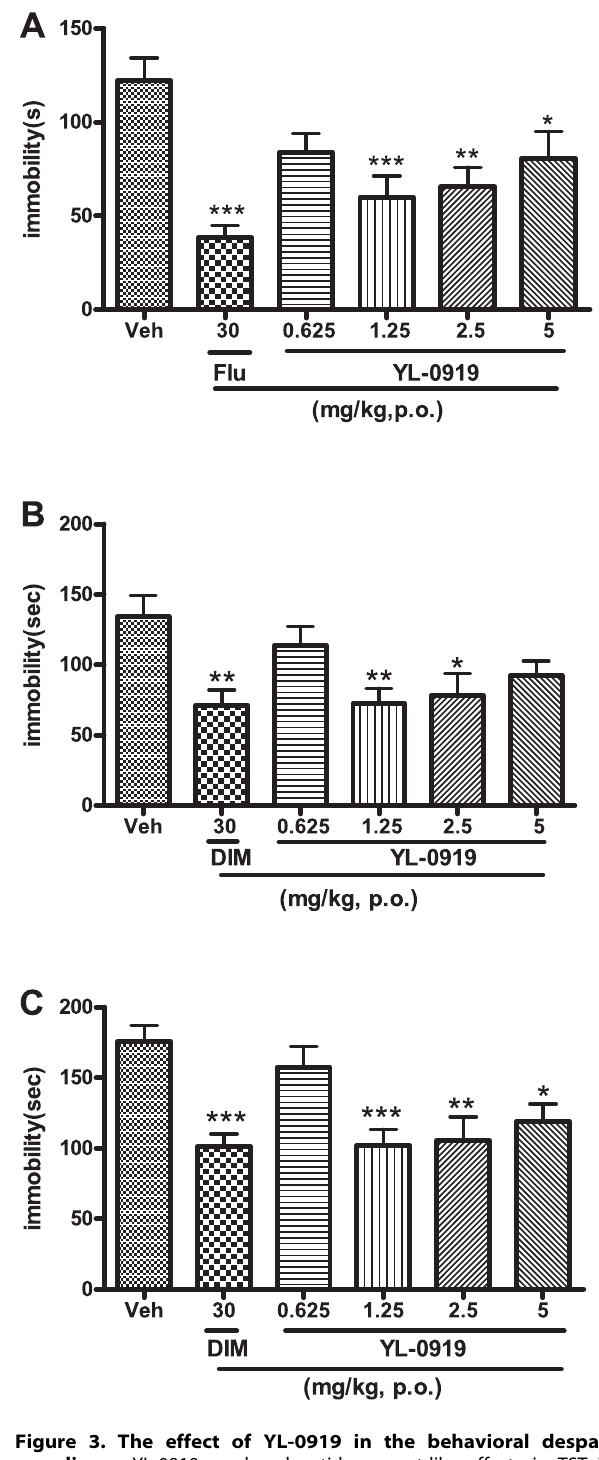
Figure 3. The effect of YL-0919 in the behavioral despair paradigms. YL-0919 produced antidepressant-like effects in TST in mcie (A), FST in mice (B) and FST in rats (C). Veh, vehicle; Flu, fluoxetine; DIM, desipramine. YL-0919, fluoxetine, or desipramine was administered p.o. 60 min prior to the test. Data are presented as means 6 SEM (n=10–12/group). * p , 0.05, ** p , 0.01, *** p , 0.001 versus